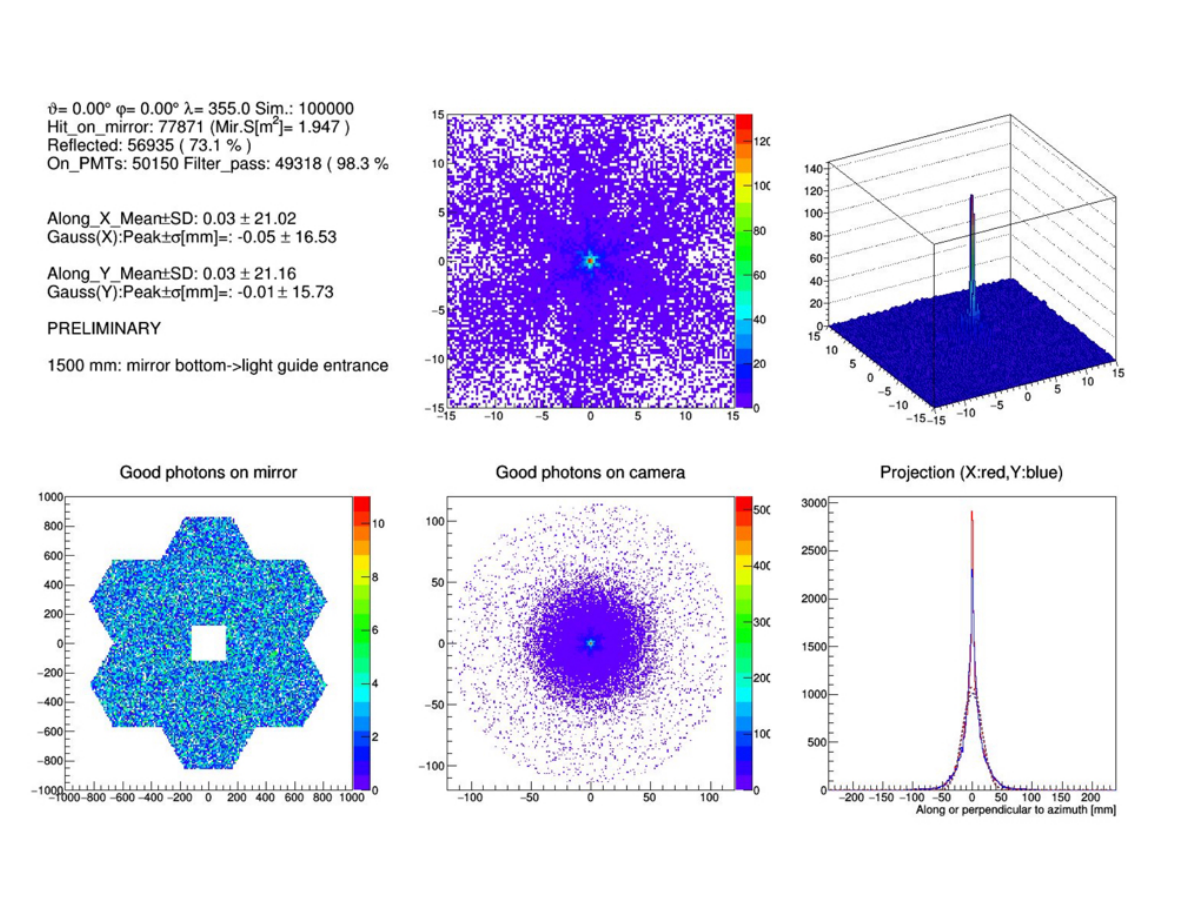
Figure 4. Simulations of the Fresnel mirror response of TUS. The bottom-right plot shows the PSF of the Fresnel optics, which is sharper in the center and broader in the tails compared to a Gaussian shape. Units in the plots are expressed in mm